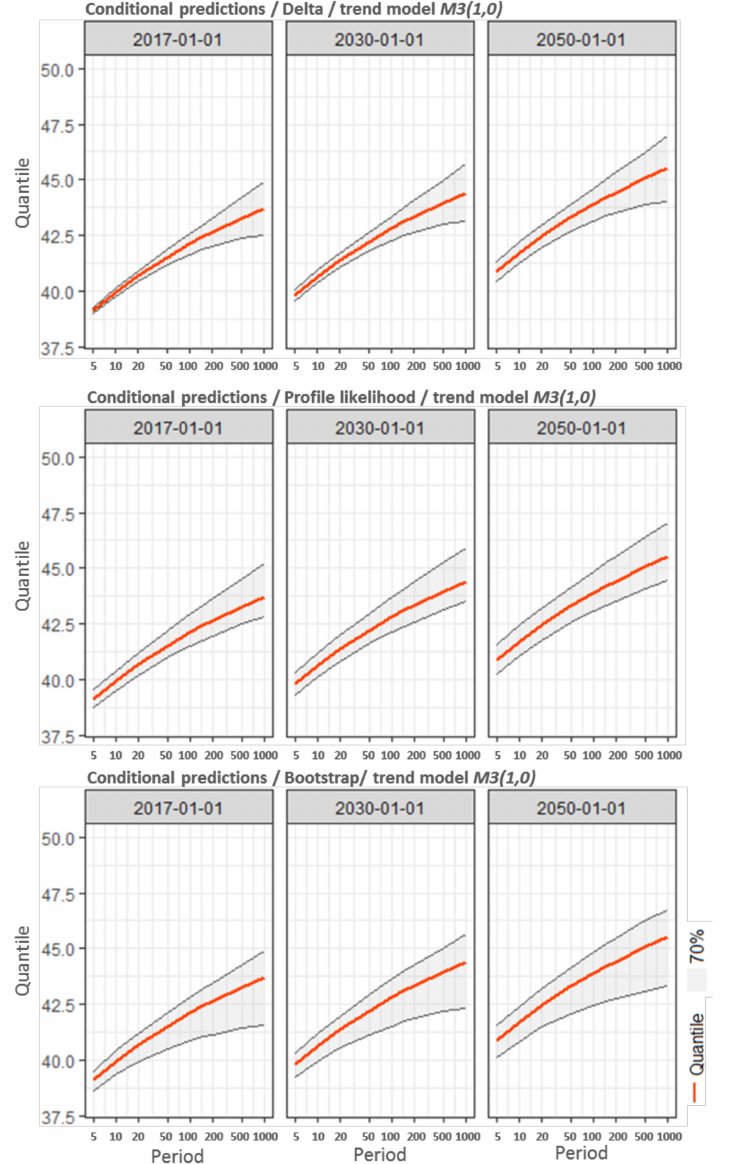
Figure 3. Conditional predictions at the Orange Station for three dates: 2017, 2030, and 2050. ( Top ) Confidence intervals calculated with the delta method; ( Middle ) confidence intervals calculated with the profile likelihood method; ( Bottom ) confidence intervals calculated with the bootstrap